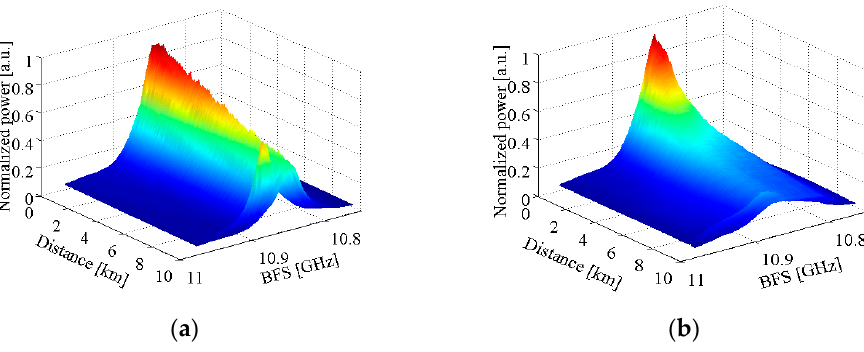
Figure 6. 3D power spectra of the local heterodyne detection Brillouin signals with ( a ) narrow-band laser and ( b ) broad-band laser. The temperature of the thermostatic water bath is set at 50 °C.